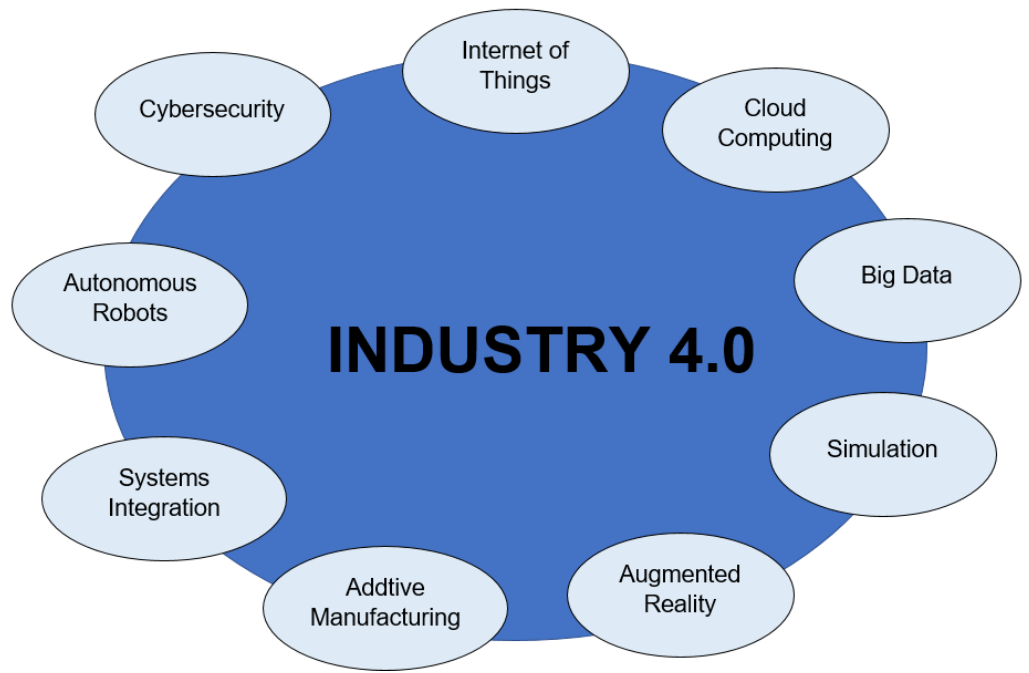
Figure 1. Basic Industry 4.0 technologies. Table 1. The summary of models to determine the digital maturity of enterprises (own elaboration based on [32 – 39]).